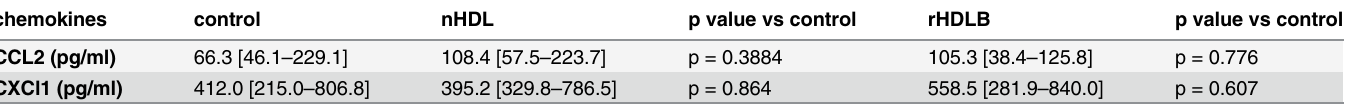
Table 1. Circulating chemokines measured 24h after reperfusion.